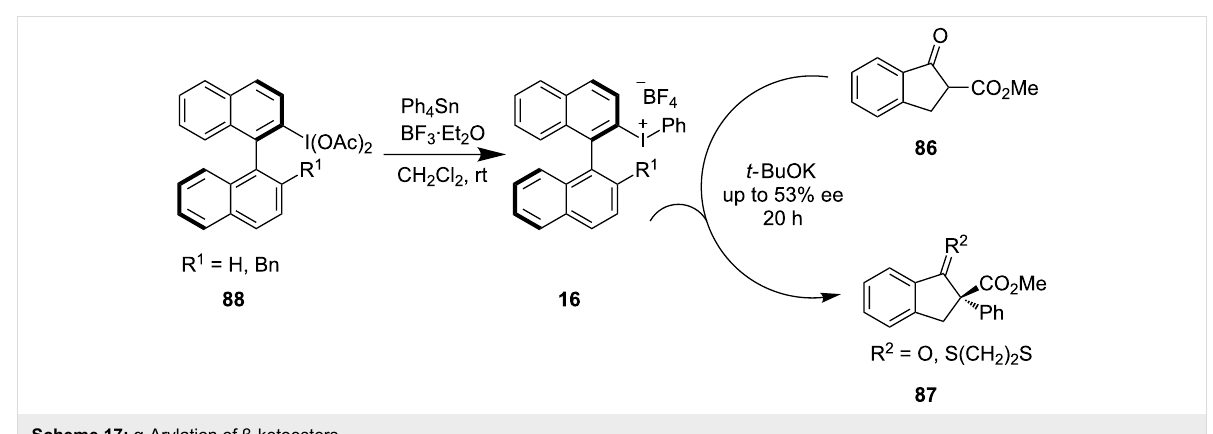
Scheme 17: α -Arylation of β